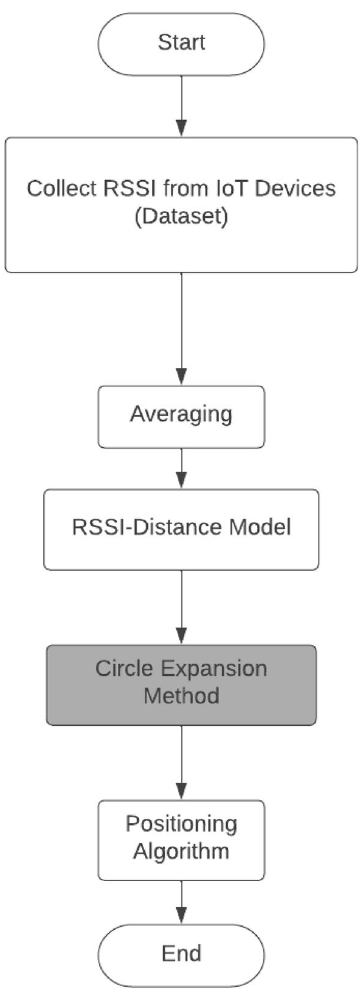
Fig. 5 Proposed adaptive positioning